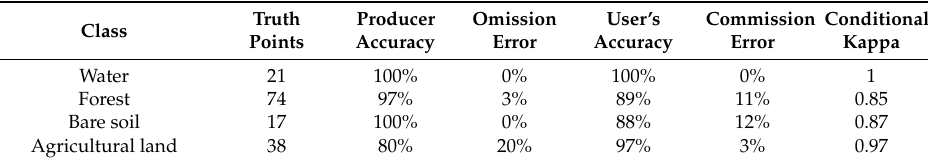
Table 3. Accuracy assessment for the classification of the 2015